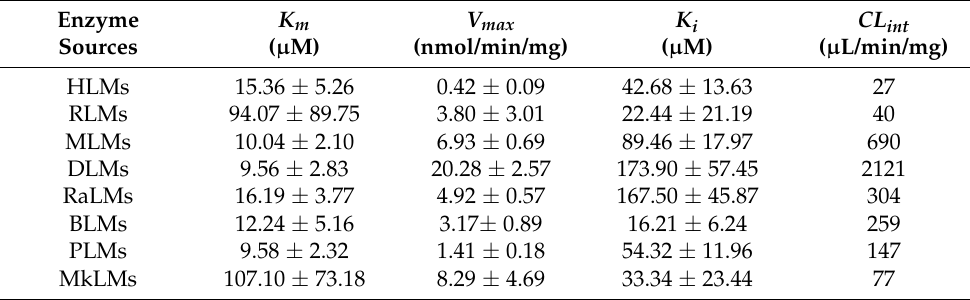
Table 1. Kinetic parameters for determination of GPC glucuronidation in HLM, RLM, MLM, DLM, RaLM, BLM, PLM, and